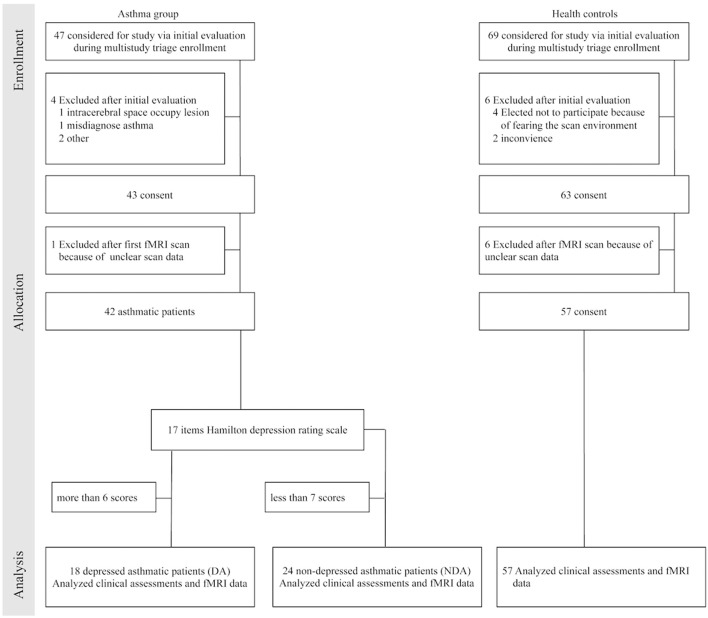
Flow diagram. fMRI indicated functional magnetic resonance imaging.